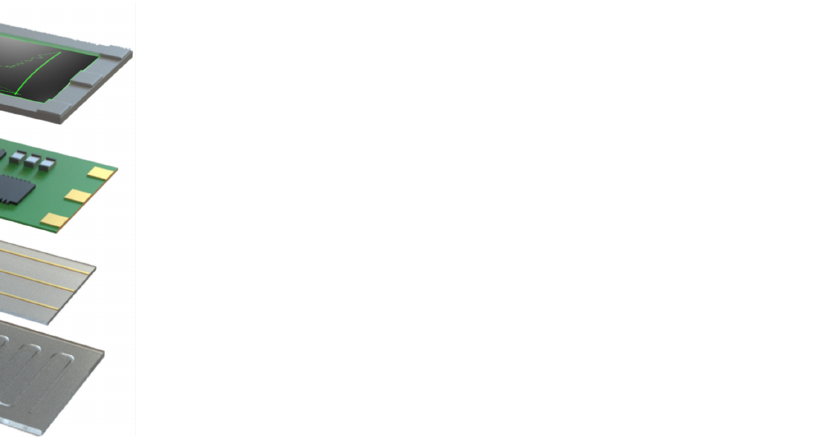
Figure 1. General schematic of different components of a wearable biosensor: ( a ) microfluidic/reagent layer, ( b ) sensing layer, ( c ) packaging layer. Depending on the biosensor’s function, other layers may be added, or existing layers might be altered to incorporate new components. For example, recombinase polymerase amplification (RPA) reagents are widely used for biomarkers or sensing probe amplifica- tion in a diagnostic assay and can be incorporated into the microfluidic channel to further enhance the detection limit. Generally, the first layer is usually a flexible polymer-based material, while the second layer includes metal or semi-conducting materials, and even- tually, the third layer entails the printed circuit board (PCB) and packaging components [28]. A variety of fabrication techniques ranging from lithography to additive manufac-